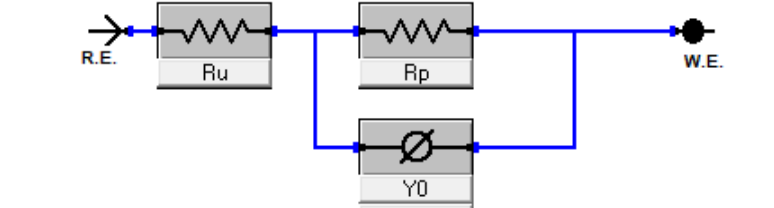
Fig. 4. Nyquist & bode plots of cold rolled and annealed alloy in the 3.5% NaCl solution along with fit data based on the models shown in Fig. 5.